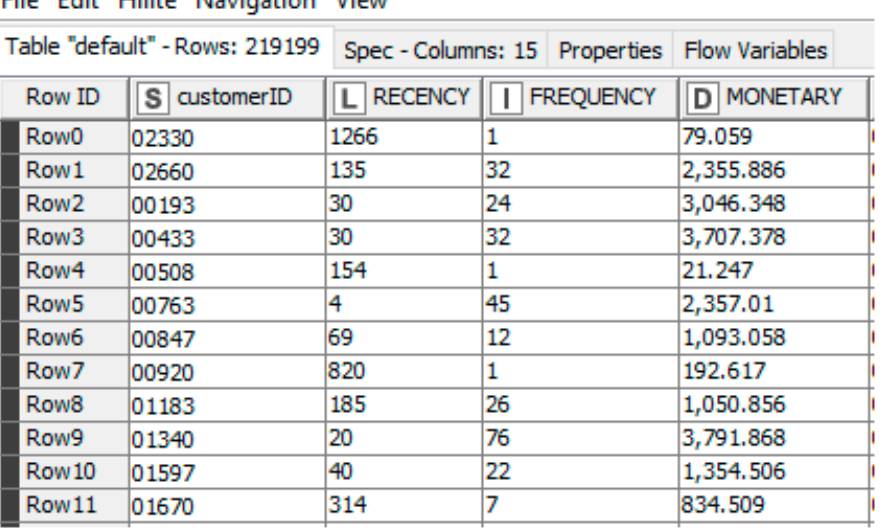
Figure 14. Output table from Knime. Sample of customers with their RFM variables.